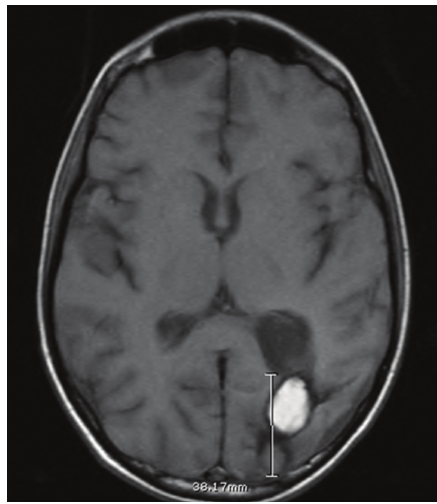
Figure 2: Invasive aspergillosis to